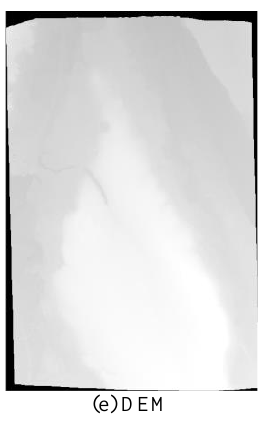
Figure 4 . Experimental result.